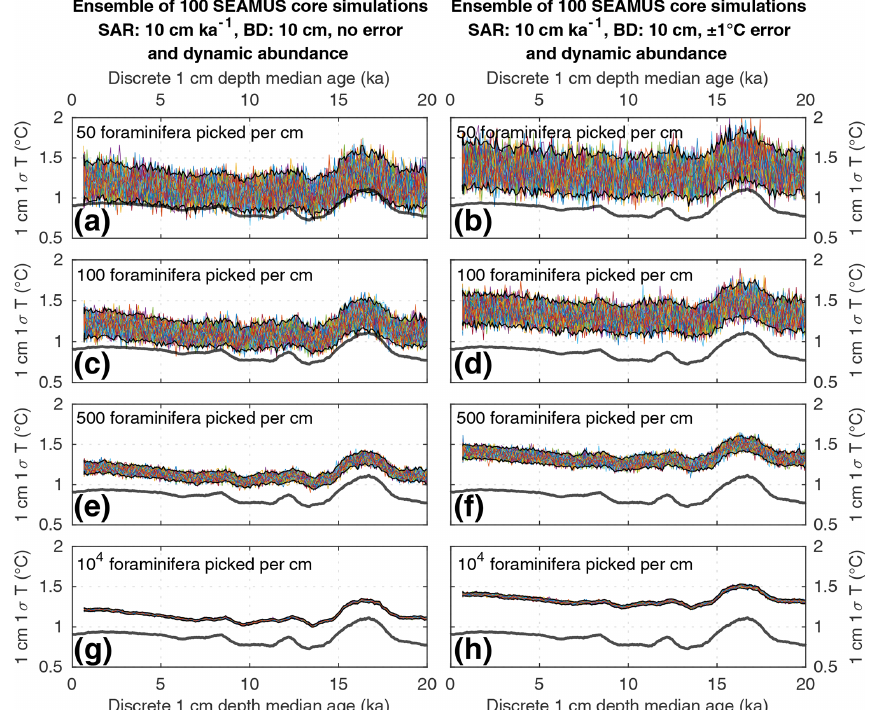
Figure 4. Simulated downcore, discrete 1cm depth 1 σ SST values of simulated single foraminifera from various 10cmkyr − 1 SAR scenarios with 10cm BD, each with 100 ensembles of SEAMUS runs. In each panel, each ensemble is shown using a coloured line. The solid black lines represent the 95% interval of the ensemble runs at each discrete 1cm depth. Also shown for reference as a thick grey line is the 1000 year (12000 month) moving 1 σ of the 1.5–7 year filtered monthly SST data (as also shown in Fig. 1c). The left panels (a, c, e, g) show the output of scenarios with 50, 100, 500 and 10 4 randomly picked foraminifera per discrete 1cm depth, all with dynamic species abundance (following Fig. 2a) and no assumed analytical error. The right panels (b, d, f, h) show the output of scenarios with 50, 100, 500 and 10 4 randomly picked foraminifera per discrete 1cm depth, all with dynamic species abundance (following Fig. 2a) and an assumed analytical error of ± 1 ◦ C in